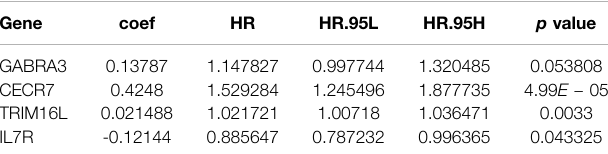
TABLE 4 | Multivariate cox analysis of TMB related genes combined with immune in fi ltrates.